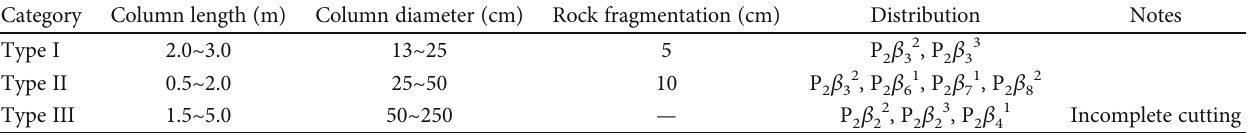
Table 1: Characteristics of columnar basalt in the dam site area of the Baihetan hydropower